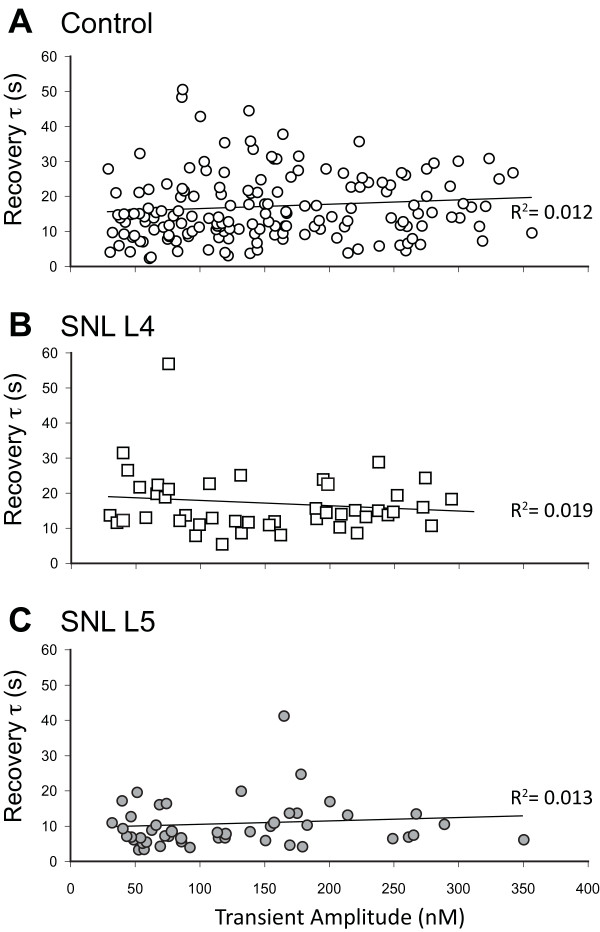
Transient amplitude does not influence PMCA function. The recovery of [Ca2+]c from transients induced by application of high K+ solution (50 mM for 0.3 s) in thapsigargin-treated neurons was measured by recovery rate constant (τ) in control neurons (A) and neurons from the 4th lumbar (L4, B) and L5 dorsal root ganglia (C) after spinal nerve ligation (SNL). In each, transient amplitude did not influence τ (regression P of 0.16, 0.36, and 0.43 respectively). The best-fit trend line and coefficient of determination (R2) are shown.